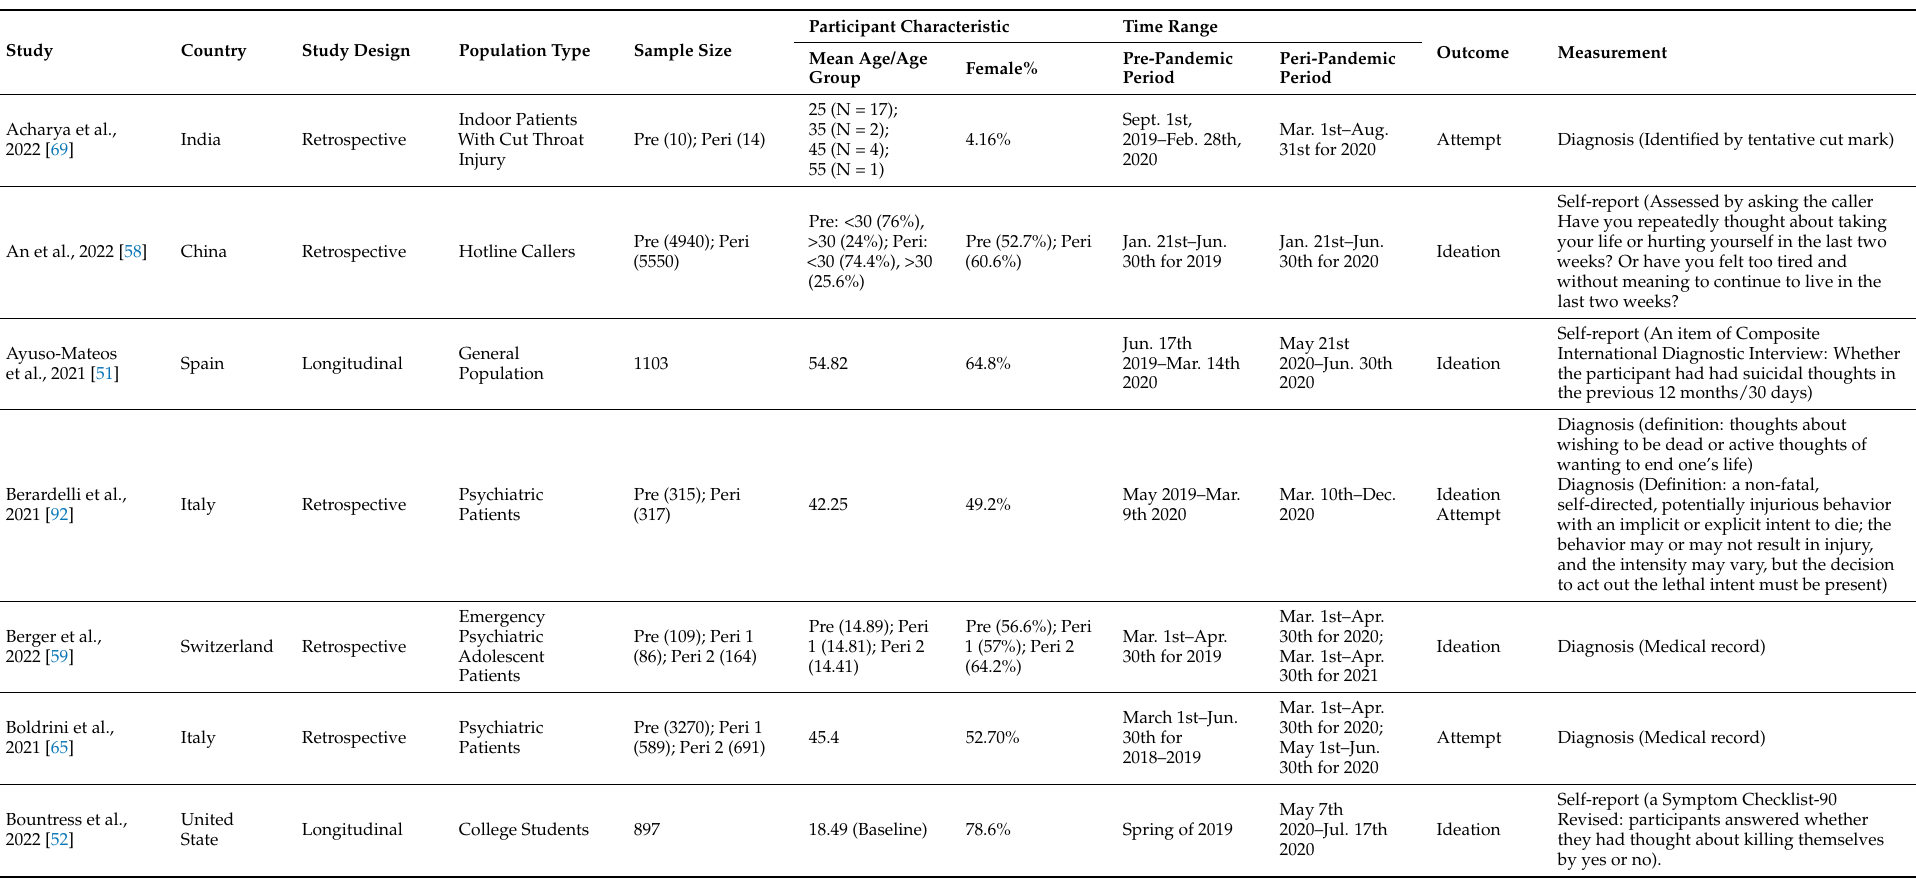
Table 1. Characteristics for studies reporting suicidal ideation and suicide